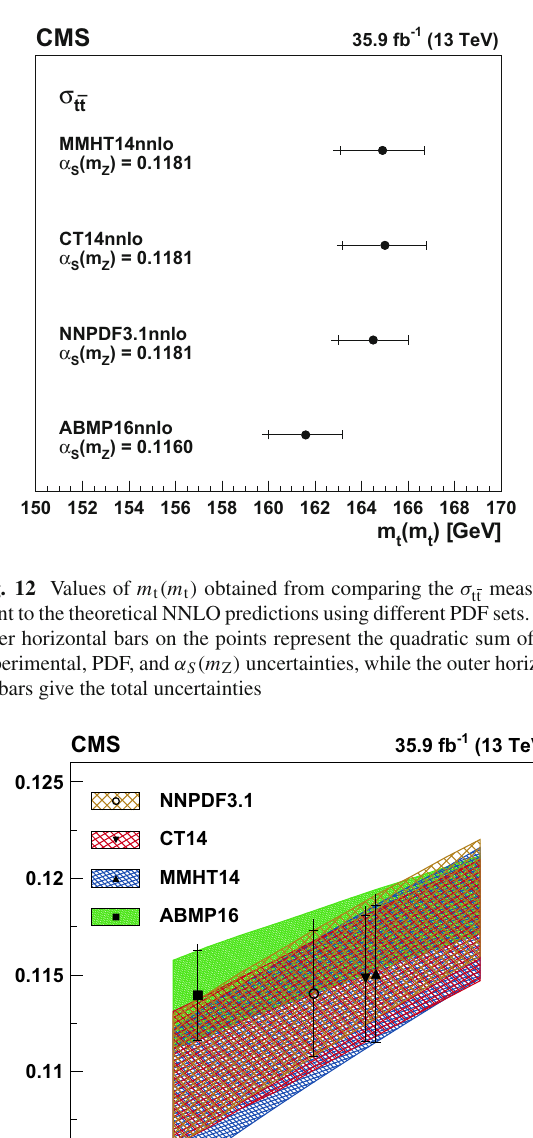
σ tt measurement